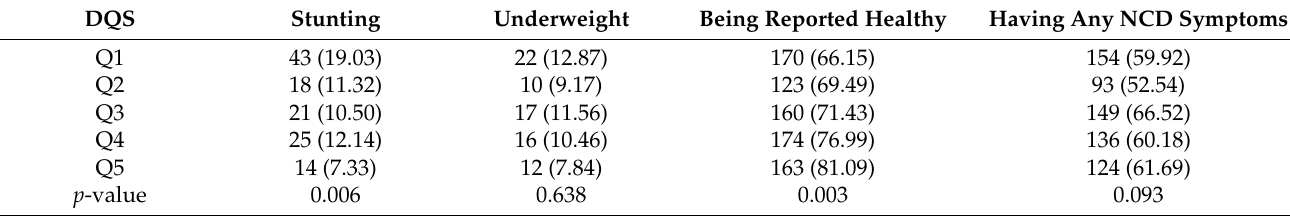
Table 2. Child health outcomes by DQS, n (%).